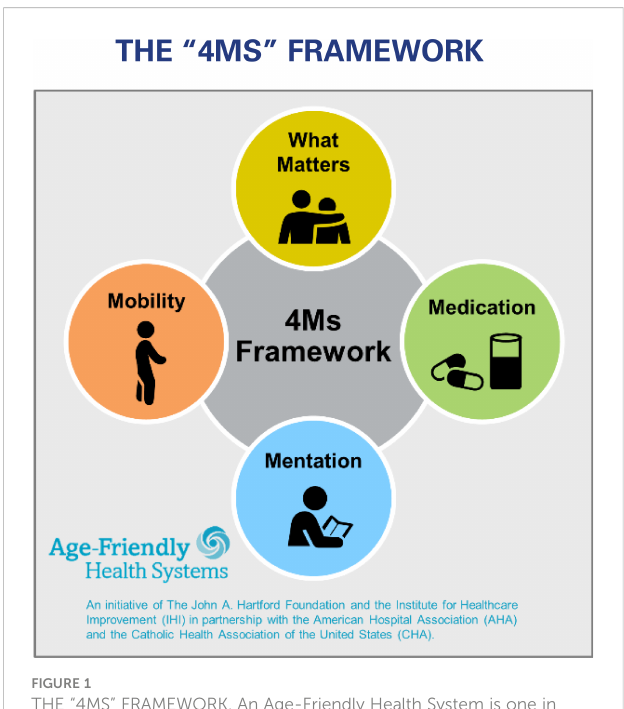
FIGURE 1 THE “ 4MS ” FRAMEWORK. An Age-Friendly Health System is one in which every older adult ’ s care: Is guided by an essential set of evidence-based practices (the 4Ms); Causes no harms; and Is consistent with What Matters to the older adult and their